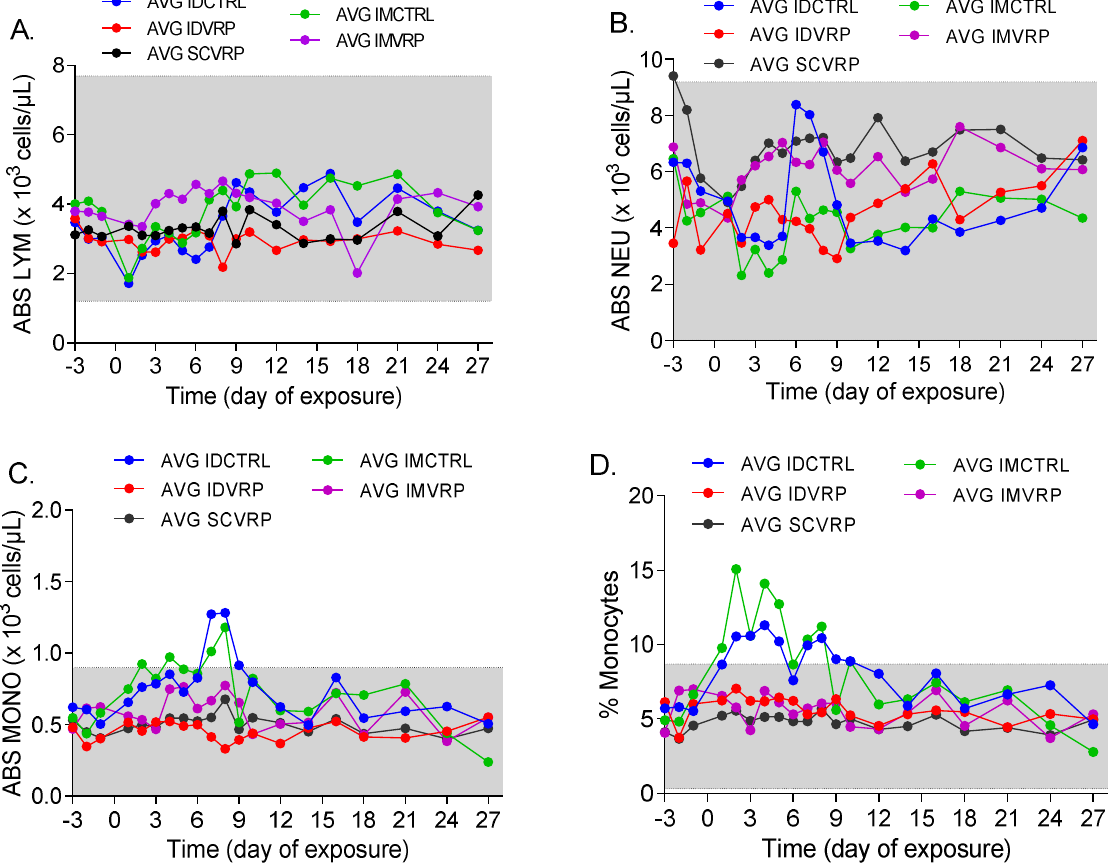
Figure 7. Hematology changes in NHPs following WEEV CBA87 exposure. Blood samples were collected on days −3 thru −1 before exposure and days 1 thru 10, 12, 14, 18, 21, 24, and 27/28 post exposure (PE) for all NHPs, except for ID CTRL-1, which was sampled at the prescribed schedule until time of euthanasia on day 8 PE. The average absolute lymphocyte ( A ), absolute neutrophil ( B ), absolute monocyte ( C ), and percent monocyte ( D ) are graphed for the control and VRP-vaccinated groups. Gray shaded areas indicate normal range for each analyte.